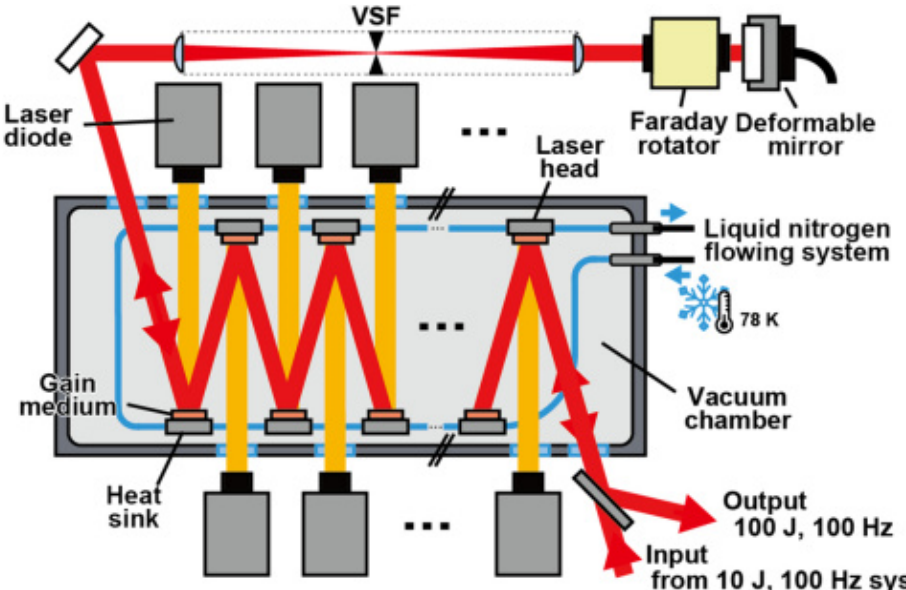
Figure 7. System layout of a 10 J class Yb:YAG cryogenically cooled active-mirror amplifier. DFB, distributed feedback; EOM, electro-optic moderator; BE, beam expander; SA, serrated aperture; TFP, thin-film polarizer [29]. [Reprinted/Adapted] with permission from [ref #] © The Optical Society. OSA requires a special citation format.